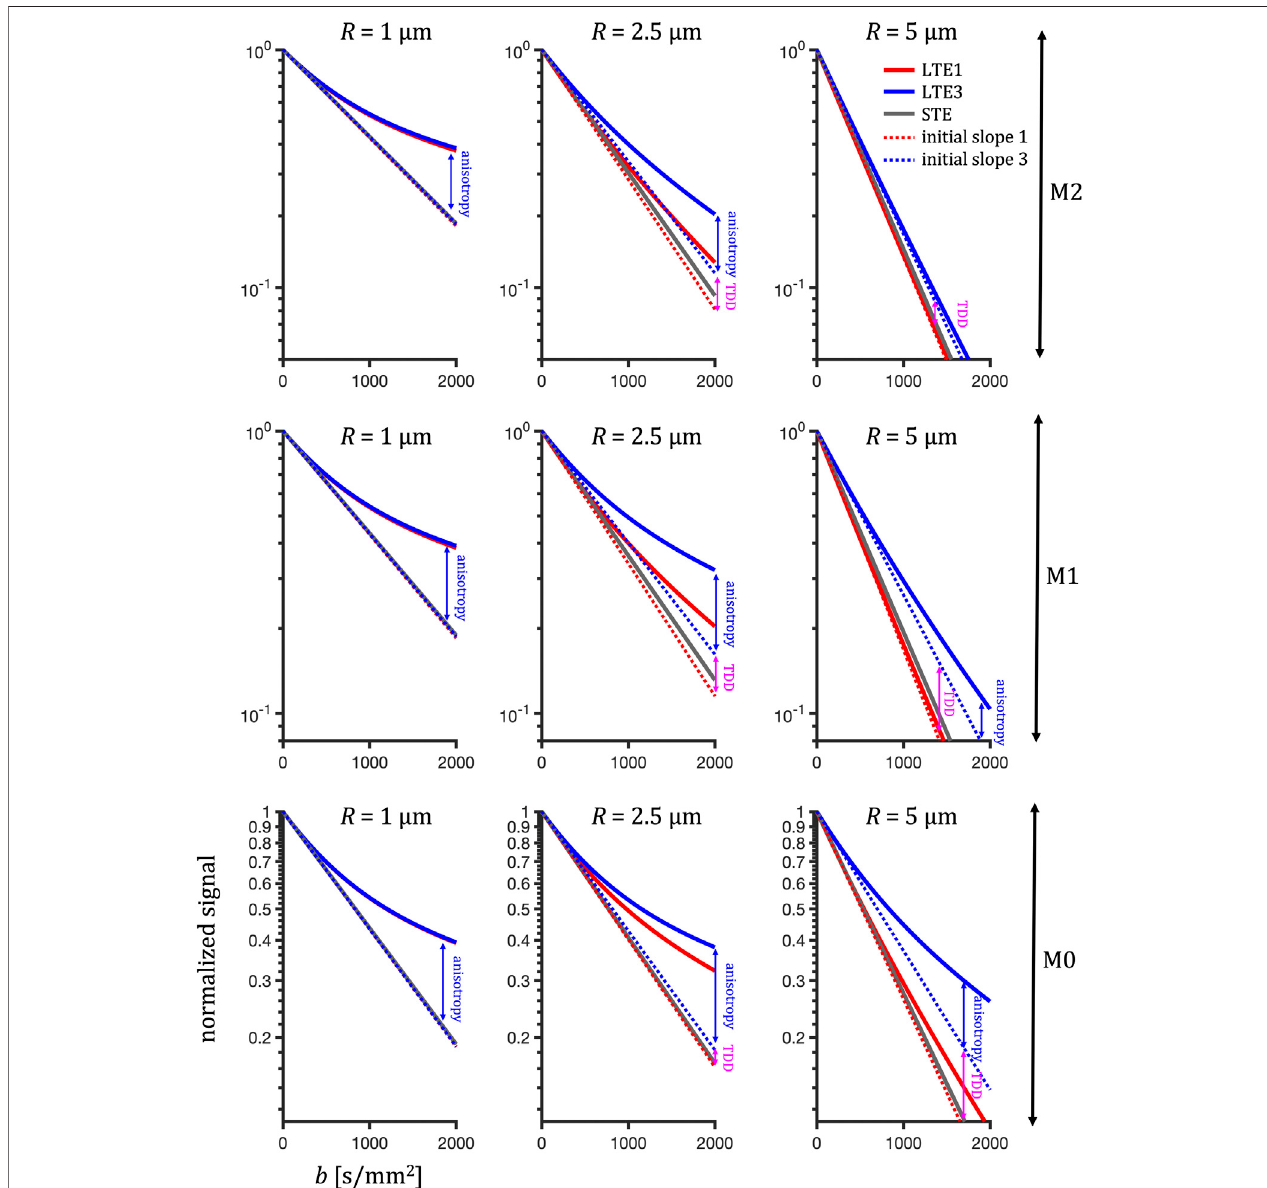
FIGURE 8 | Predicted signal vs. b-value illustrating the competing effects of anisotropy and TDD at different sizes. Rotation-average signals are calculated from apparent diffusivities in 15 randomly oriented cylinders ( D 0 = 2.48 μ m 2 /ms, radius R ) probed by the preclinical encoding waveforms LTE1 (red), LTE3 (blue) and STE (grey) with varying degrees of motion compensation (M0-M2, bottom to top rows). Dotted lines indicate attenuation in the limit of low b-values. Arrows mark the differences due to anisotropy and TDD (visible at intermediate and large sizes). For small restrictions, the initial attenuations coincide and the signal deviation between LTE and STE at higher b-value is due to compartment anisotropy. With increasing cylinder radius the difference between size sensitivities of different encoding waveformsbecomevisible.NotethehighersignalsfortheLTE3comparedtotheLTE1andsimilarinitialslopesforLTE1andSTE.Forverylargecylinders,theanisotropic diffusion variance (mean kurtosis) is overshadowed by an increased MD and can no longer be detected (for M1 and M2). However, the effect of TDD on MD remains clearly visible.